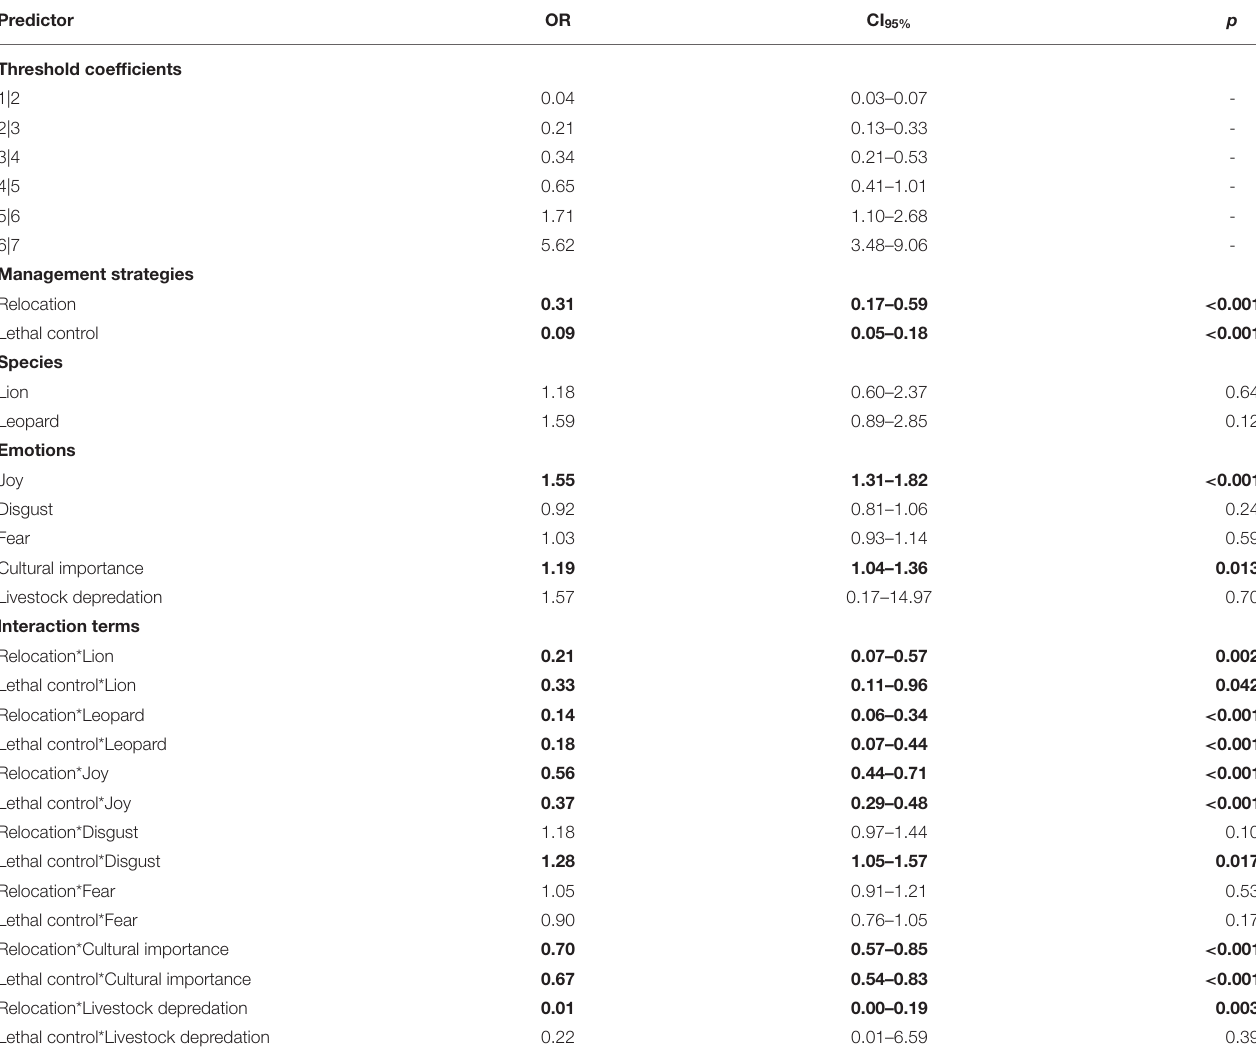
TABLE 2 | Variation in acceptance scores by Maasai pastoralists as a function of management strategies, carnivore species, emotions, cultural importance, and livestock depredation.